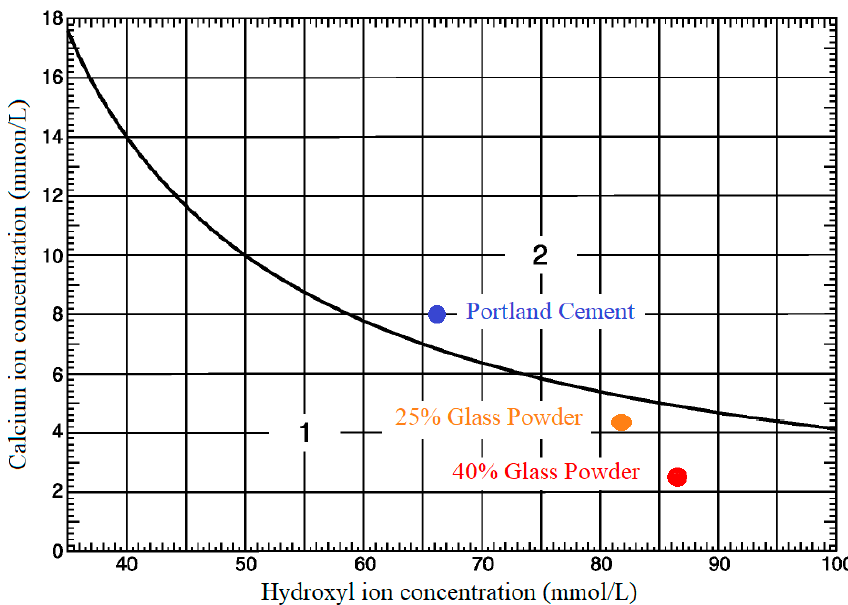
Figure 4. Calcium ion concentration vs. hydroxyl ion concentration in GP and CEM.